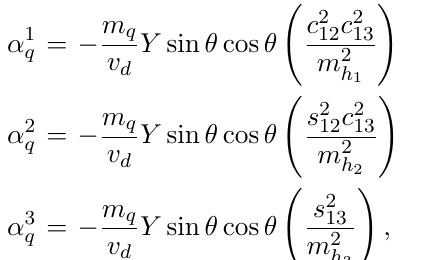
Figure 7 . Left: relic density allowed parameter space in M (the colour codes are same as (cid:12)gure 4). The present bound from XENON1T is shown by the orange thick dashed curve, while the grey region below corresponds to the neutrino (cid:13)oor: neutrino-nucleon coherent elastic scattering. Right: parameter space available in M bounds from both relic abundance and direct detection (colour codes are same as